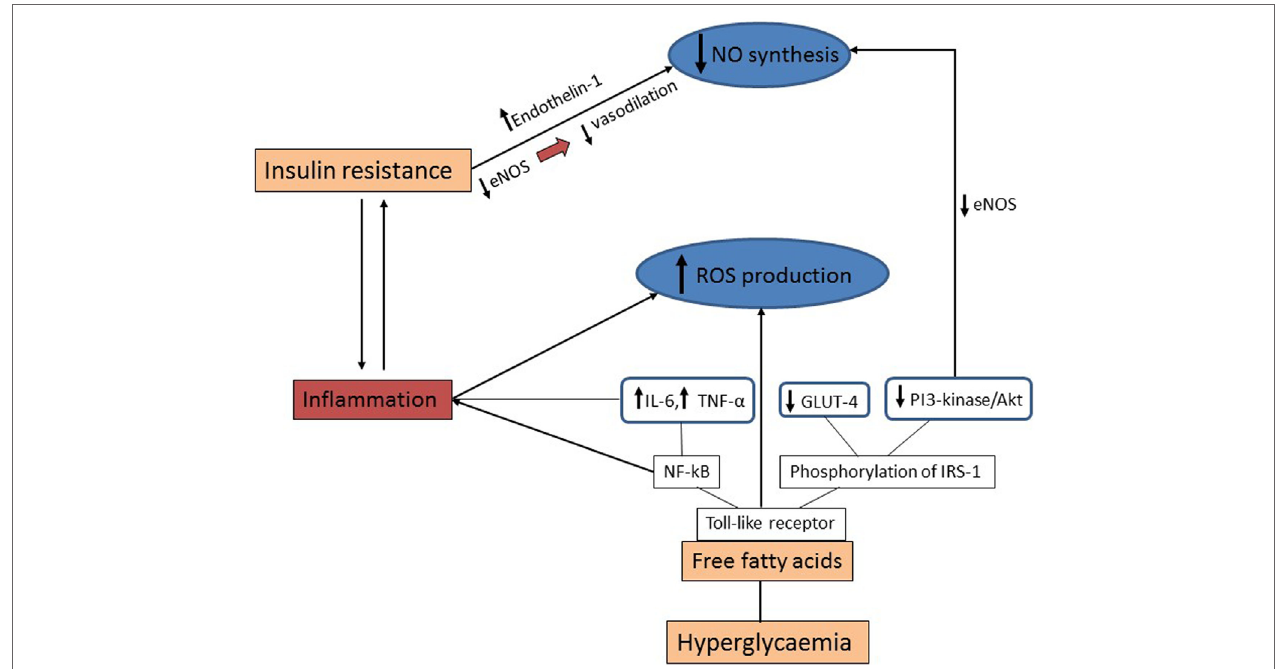
FigURe 2 | Mechanistic pathways for increased vascular inflammation in diabetes. Insulin resistance inhibits nitric oxide (NO) synthesis by reducing vasodilation via decreased activity of endothelial NO synthase (eNOS) together with increased production of vasoconstrictors such as endothelin-1. Hyperglycemia and increased levels of free fatty acids enhance the production of reactive oxygen species (ROS) and reduce NO synthesis via several cellular mechanisms. Free fatty acids bind to toll-like receptor which activates the NF- κ B pathway and stimulates inflammation by increasing interleukin (IL)-6 and tumor necrosis factor (TNF)- α . Additionally, toll-like receptor stimulates the phosphorylation of insulin receptor substrate-1 (IRS-1) followed by downregulation of the PI3-kinase/Akt pathway and the glucose transporter GLUT-4, consequently resulting in reduction of NO